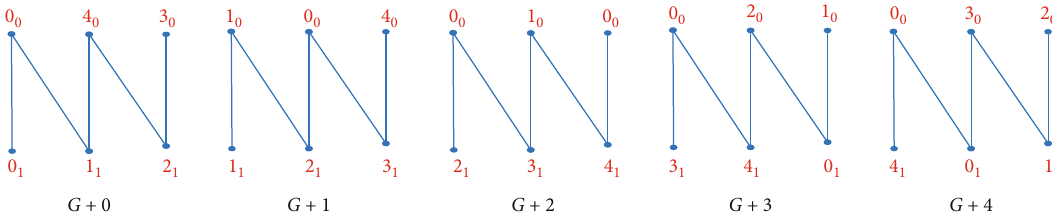
Figure 1: An edge decomposition of K